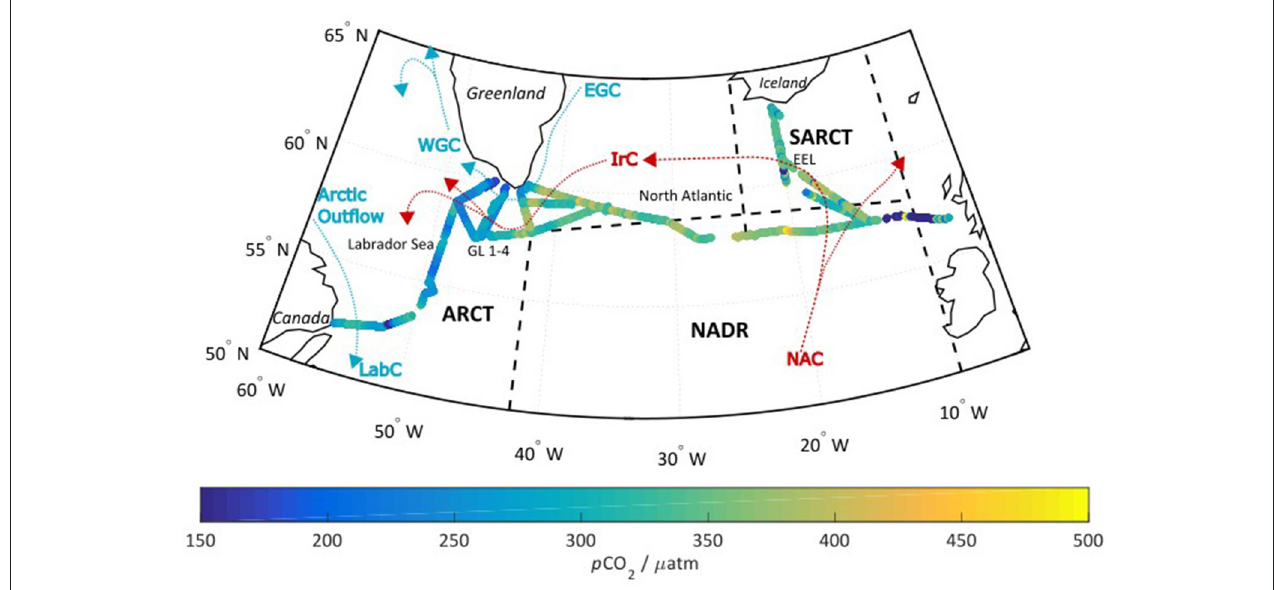
FIGURE 1 | The cruise track overlaid with the optode measured pCO 2 in µ atm. The black dashed lines indicate the different biogeographical regions discussed in section Factors Controlling Surface Seawater pCO 2 across the Subpolar North Atlantic, while the red and blue arrows indicate the respective “warm” and “cool” surface currents. SARCT = Sub-Arctic (58–68 ◦ N, 24–10 ◦ W), ARCT = Arctic (50–70 ◦ N, 60–10 ◦ W), and NADR = North Atlantic Drift (44–58 ◦ N, 42–10 ◦ W). Further divisions can be made within the ARCT region into the central Labrador Sea, and the four transects around the Greenland coastline (termed GL 1-4). The SARCT region comprises mostly the repeat hydrographic transect the Extended Ellett line (EEL). The main currents are the NAC, North Atlantic Current; IrC, Irminger Current; EGC, East Greenland Current; WGC, West Greenland Current; LabC, Central Labrador Sea water, with Arctic outflows referring to Arctic waters that reach the Labrador Sea via the Canadian